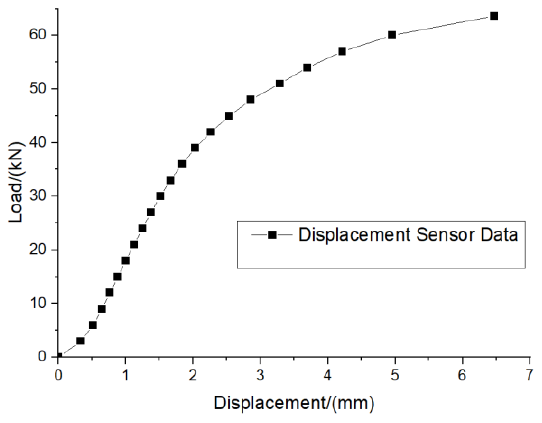
Figure 10. Failed test structure component in tensile test.